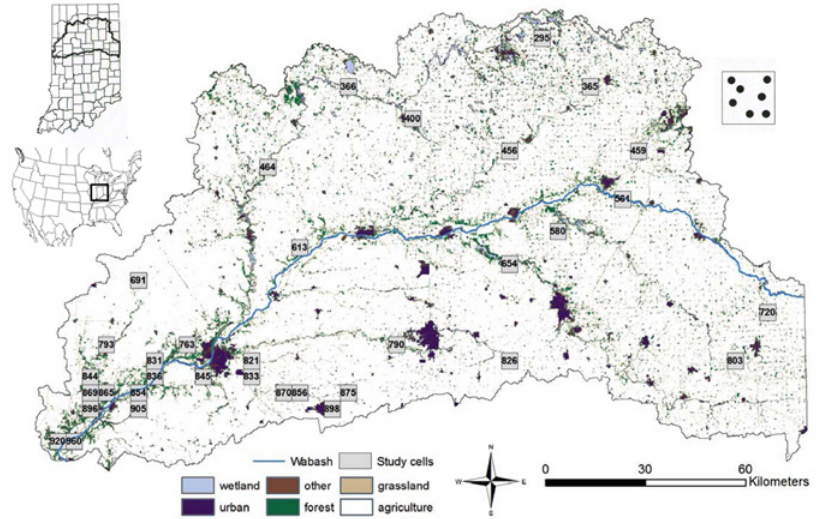
Fig 1. Map of study area in northern Indiana showing distribution of study cells. The blue line corresponds to the Wabash River, and land cover is colored. Right inset demonstrates several sample sites within each study cell. Left inset shows the study area location in North America and Indiana with counties outlined. All study cells are labeled by their ID.